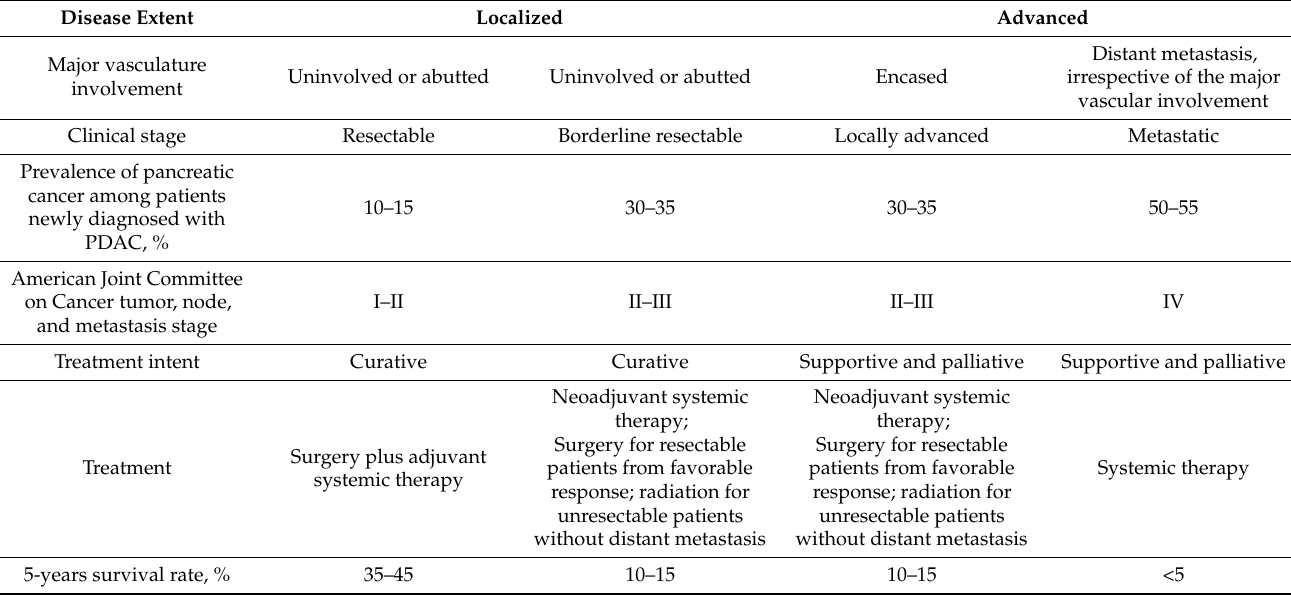
Table 1. PDAC prognosis and treatment by stage